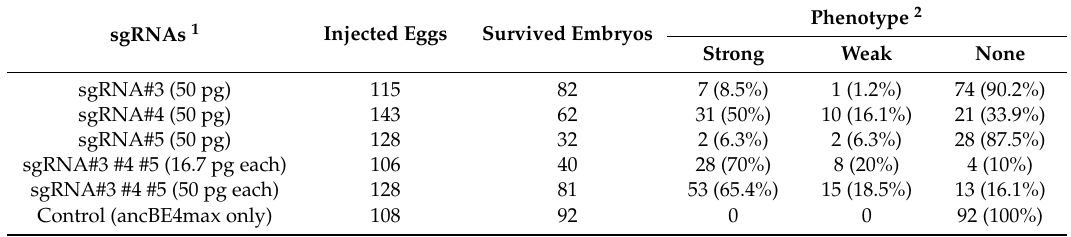
Table 1. Phenotypic penetrance of base edited animals with single sgRNA (small guide RNA) or multiplex sgRNAs.